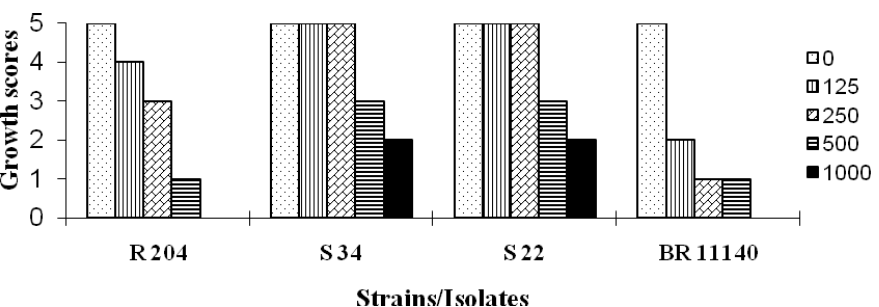
Fig. 1 – Growth scores of associative diazotrophic bacteria isolated from heavy metal contaminated area and type strains in potato dextrose agar medium supplemented with different concentrations of Zn 2+ (mg L -1 ) ten days after inoculation. a) Azospirillum lipoferum (1S and BR 11080 T ) and A. brasilense , (1R, S181, R214, BR 11001 T ); b) A. amazonense (R204, S34, S22, BR11140 T ). 0 = no visual growth, 1 = very reduced growth, 2 = low growth, 3 = intermediate growth, 4 = abundant growth, 5 = very abundant growth as compared to the growth of the strain/isolate in the same medium without heavy metal